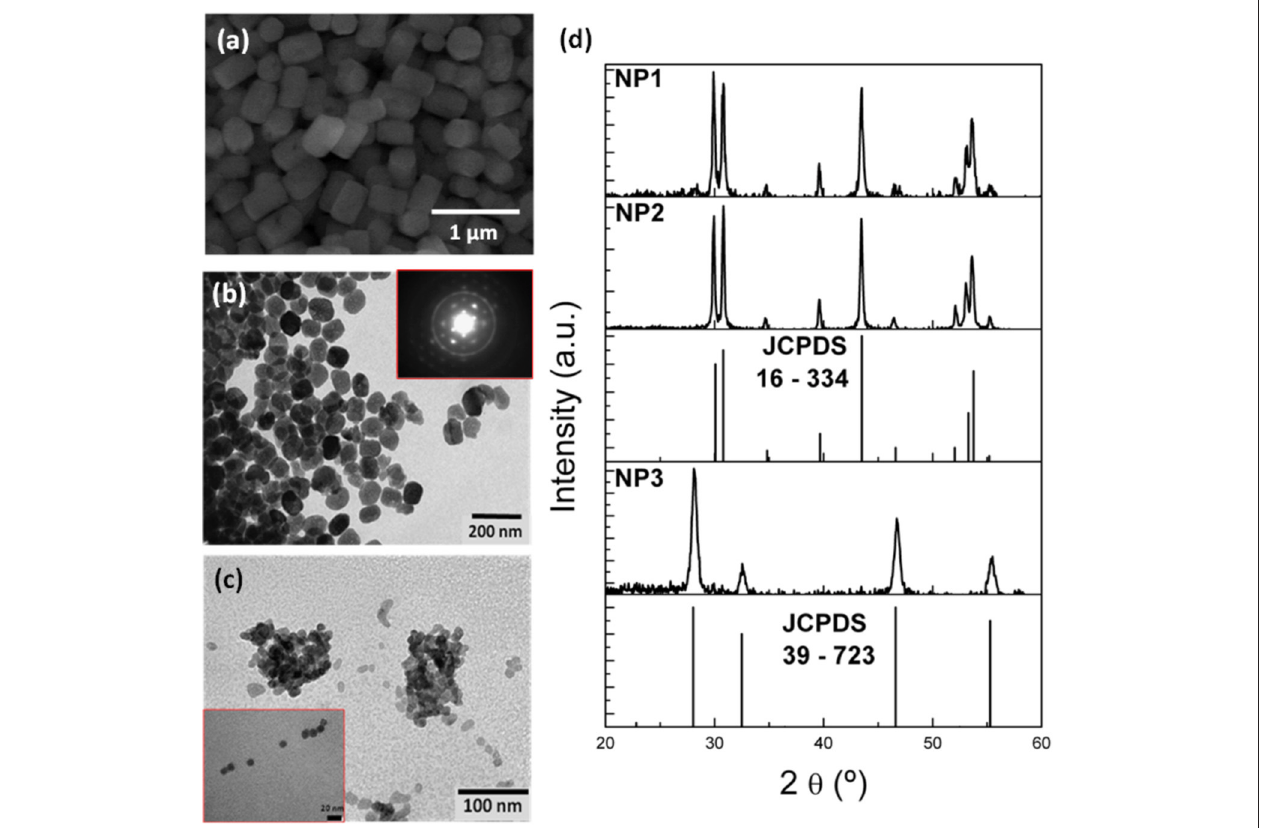
FIGURE 1 | (a) ESEM image of the nanoparticles obtained in the NP1 sample. TEM images of the nanoparticles obtained in the (b) NP2 and (c) NP3 samples. (d) X-ray diffraction patterns of the samples, together with the reference diffraction patterns for the α - and β -NaYF 4 crystalline phases.